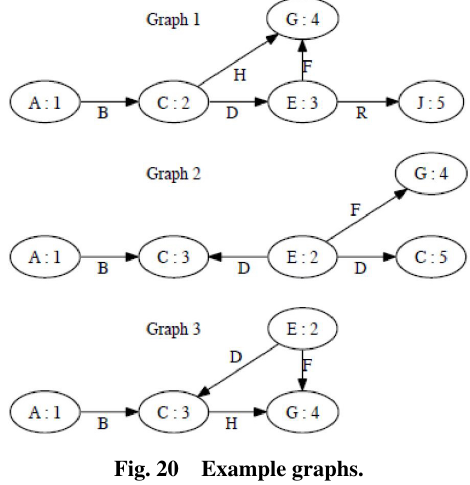
Fig. 20 Example graphs.